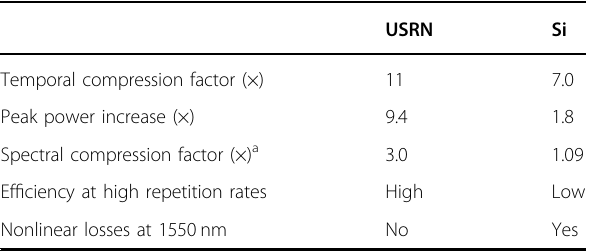
Table 2 Comparison between USRN compressor (this work) and ref.